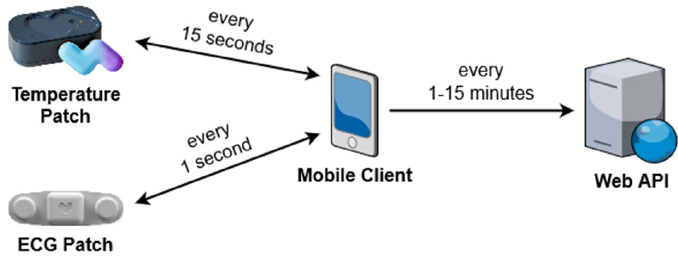
Figure 3. Communication between patches, mobile device, and server.